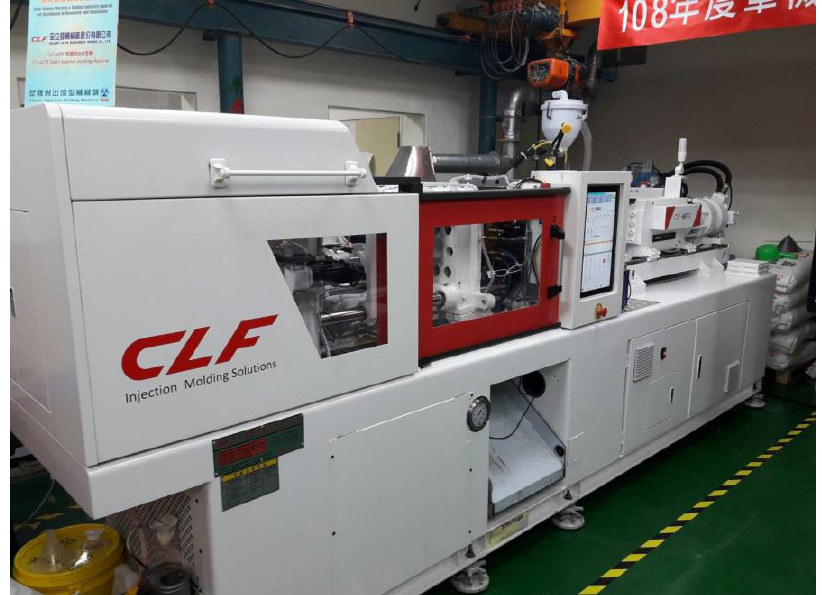
Figure 8. Injection-molding machine.